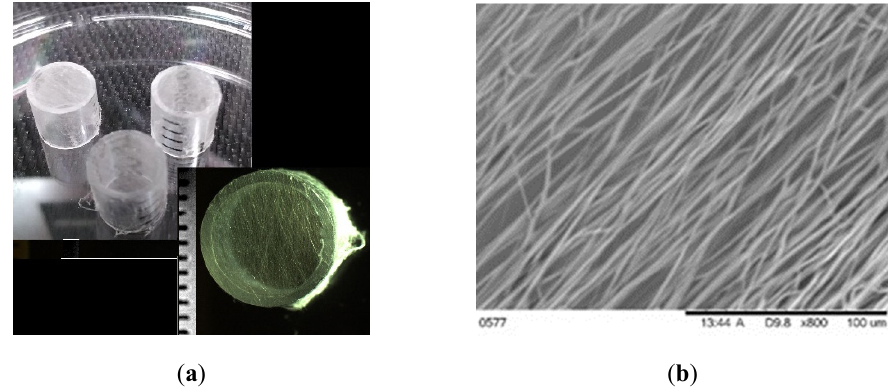
Figure 4. ( a ) Produced PCL fiber membrane on a tube collector. The inset picture shows the PCL fiber mesh completely covered the hole of the tube; tick marks are 1 mm apart. ( b ) SEM image of an arbitrarily selected PCL fiber membrane from the produced samples before immobilization with GSH. Table 1. Percentage of weight change of different sample groups after 10 and 20 days in soaking PBS (n = 5).